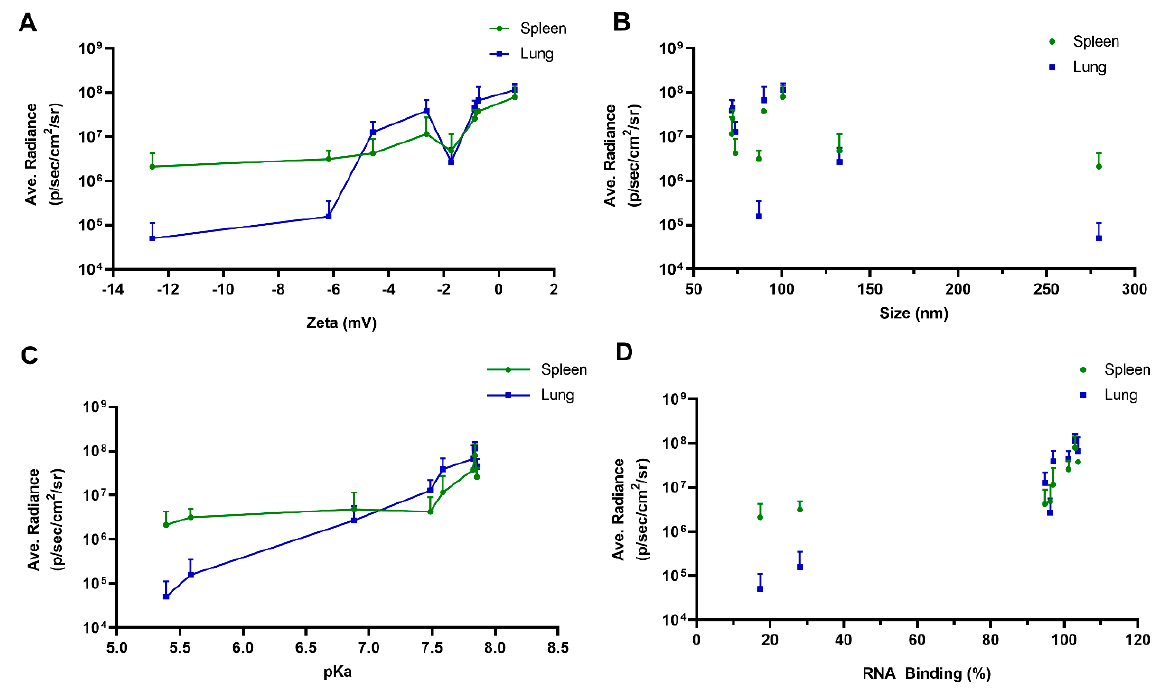
Figure 5. Correlations between ex vivo luminescence intensity and physicochemical properties of mRNA polyplex. ( A ) Surface charge versus luminescence intensity. ( B ) Size versus luminescence intensity. ( C ) pKa versus luminescence intensity. ( D ) RNA binding versus luminescence intensity (mean ± s.d., n = 3).